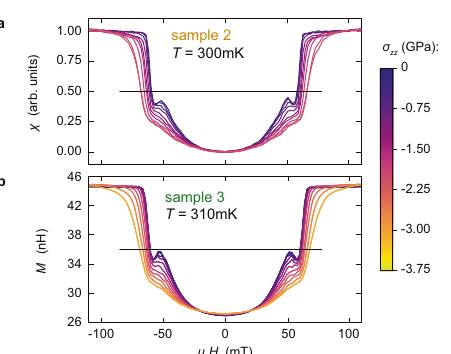
normalized by the readings at 0 and 100mT. The horizontal lines indicate the thresholds for determination of H c2 . c H c2 ( T ≈ 0.3K) versus stress for samples 2 and 3. d H c2 = T 2 c , normalized by its zero-stress value, versus stress for sample